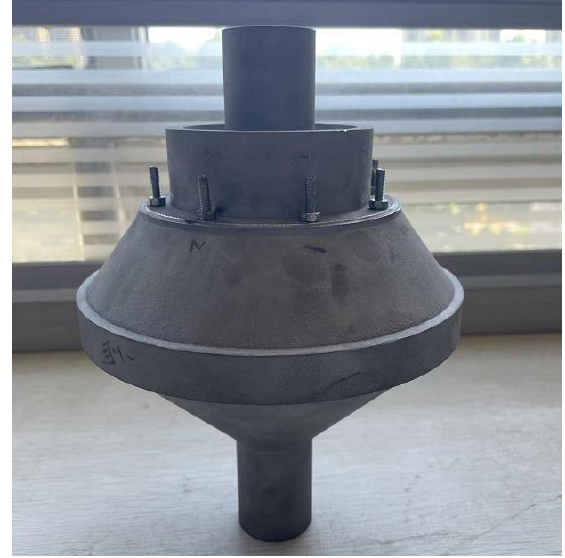
Figure 2. Simplified experimental parts.